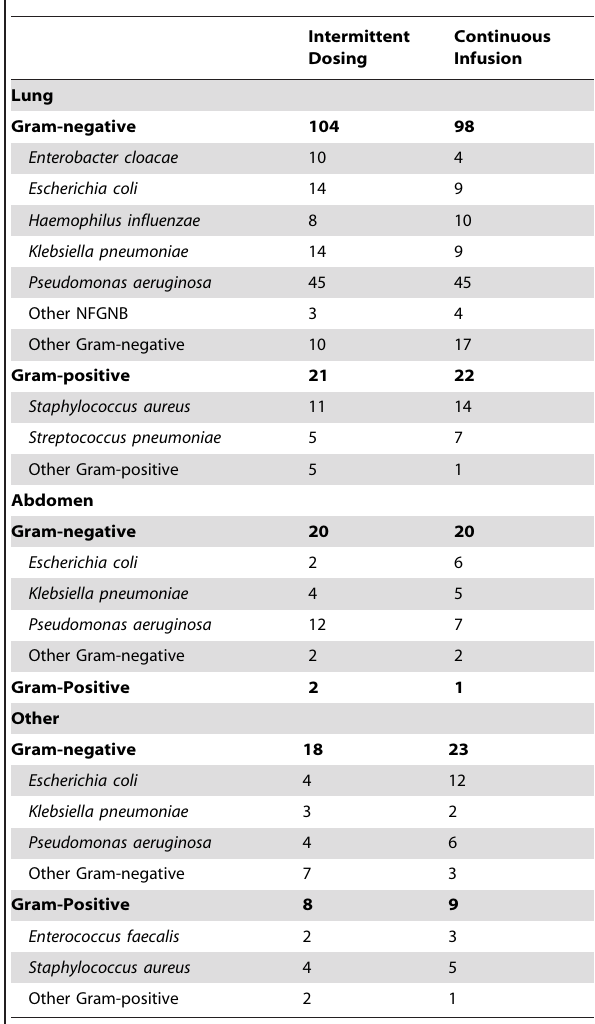
Table 2. Main microorganisms